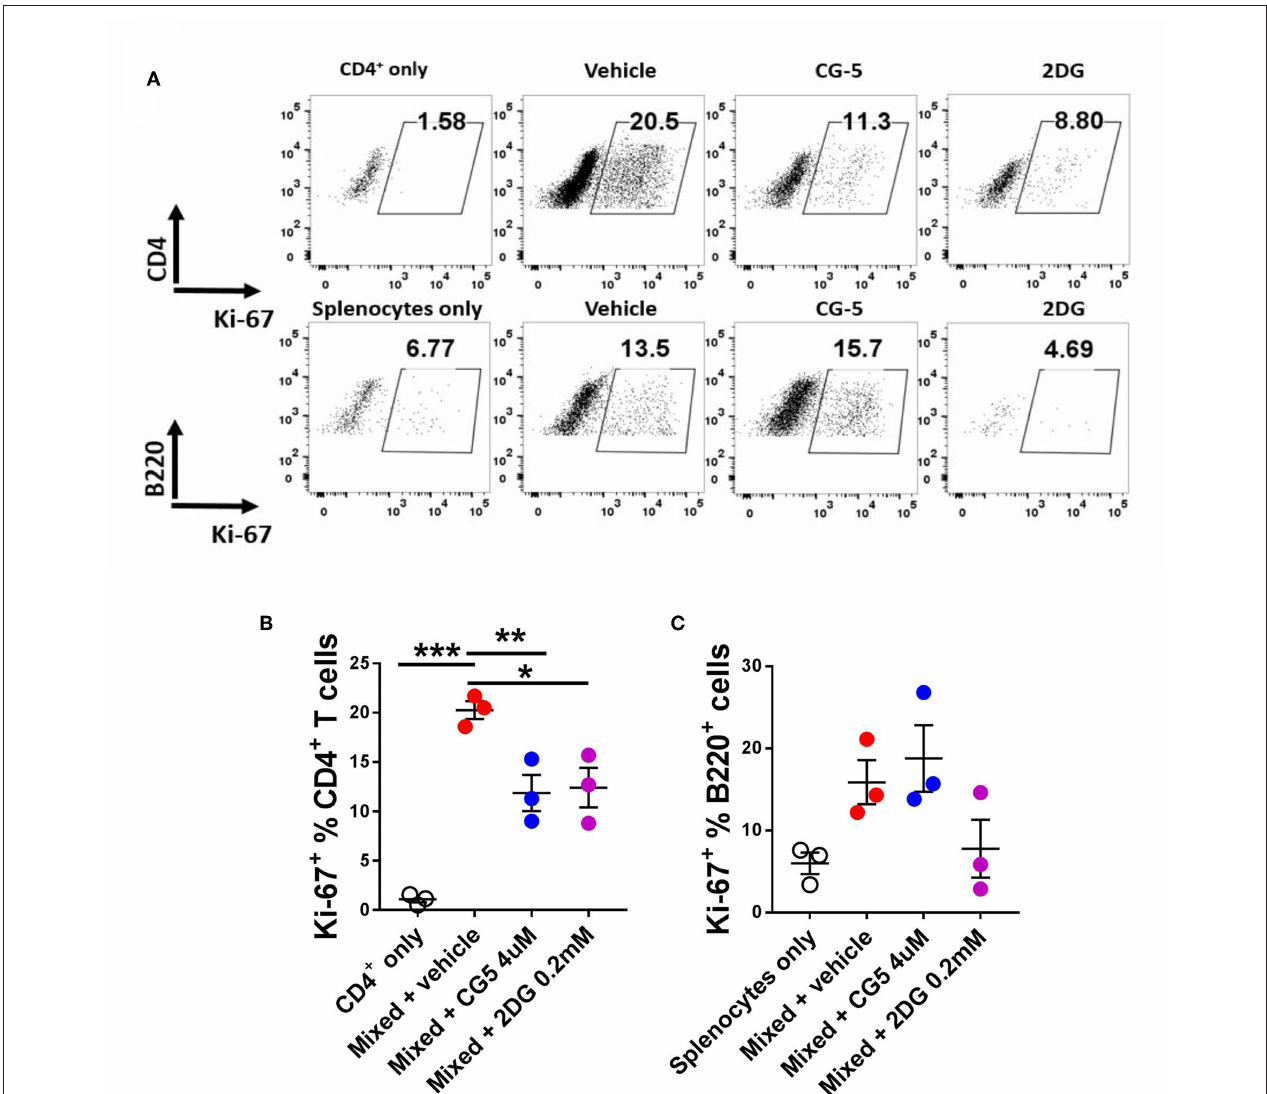
FIGURE 4 | CG-5 inhibits CD4 + T cell alloreactivity. CD4 + T cells isolated from Bm12 mice were mixed with splenocytes from TCR β KO mice in the presence of vehicle, CG-5, or 2DG for 4 days. (A) Representative FACS plots. Frequency of Ki-67 expression in CD4 + T cells (B) and B220 + B cells (C) . Mean ± S.E.M of n = 3–5 per group compared with mixed + vehicle-treated group using one-way ANOVA. * p < 0.05; ** p < 0.01; *** p < 0.001.